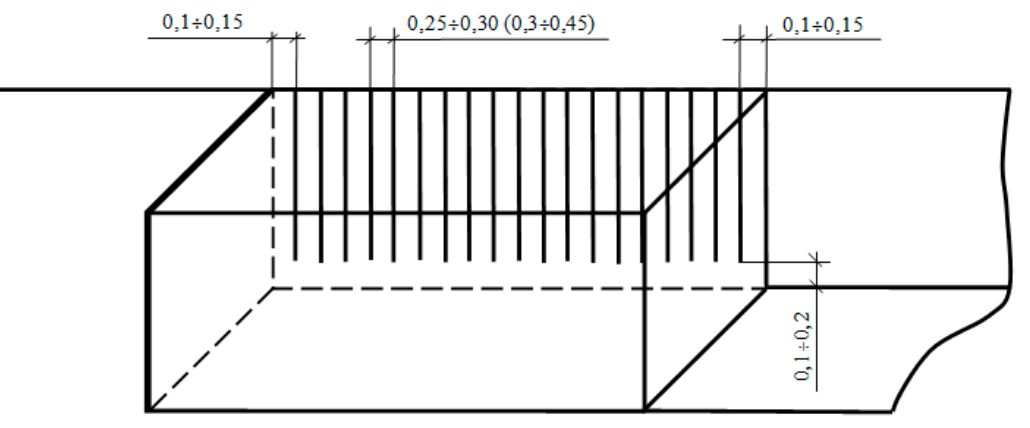
Figure 6. Diagram of hole spacing when mining blocks (Adapted from [16]).